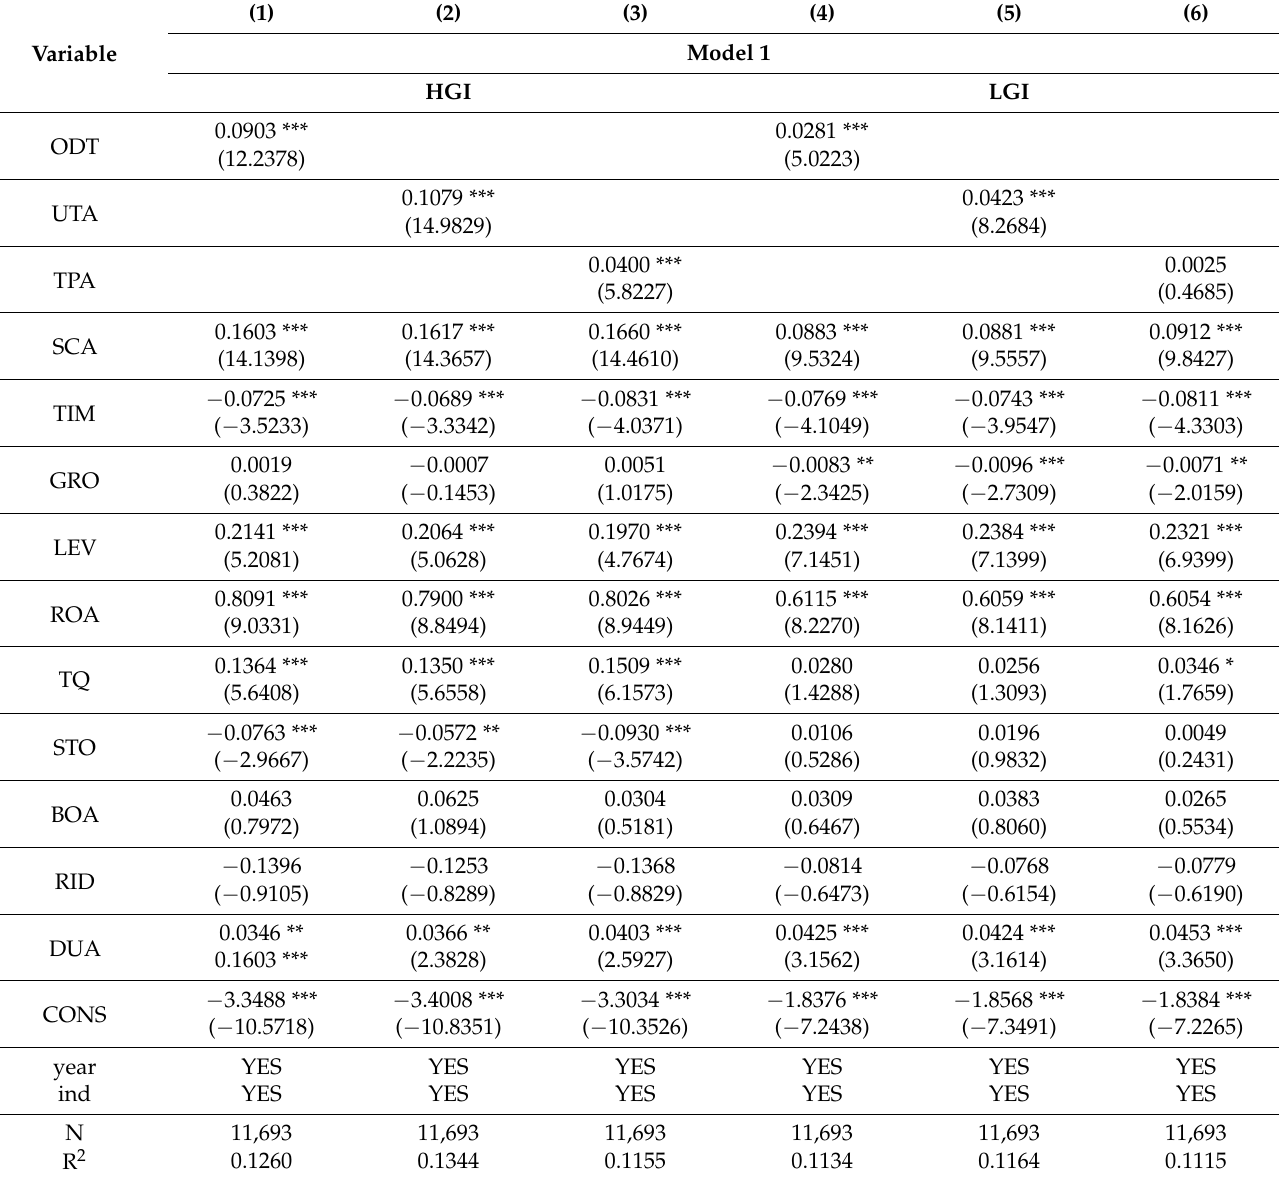
Table 7. Group test results according to green innovation